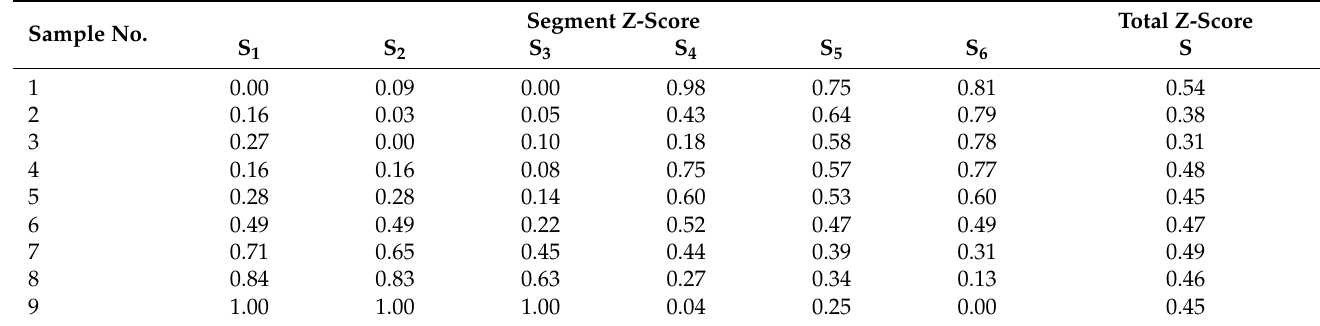
Table 7. Z-score analysis of cookies with and without the addition of L and OL